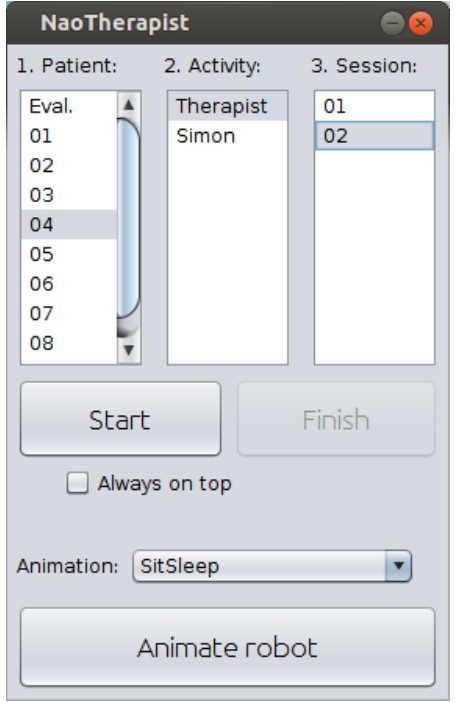
Figure 5. Session launch. This view allows for starting a previously defined session with a specific patient. In addition, the Simon game can also be started from this